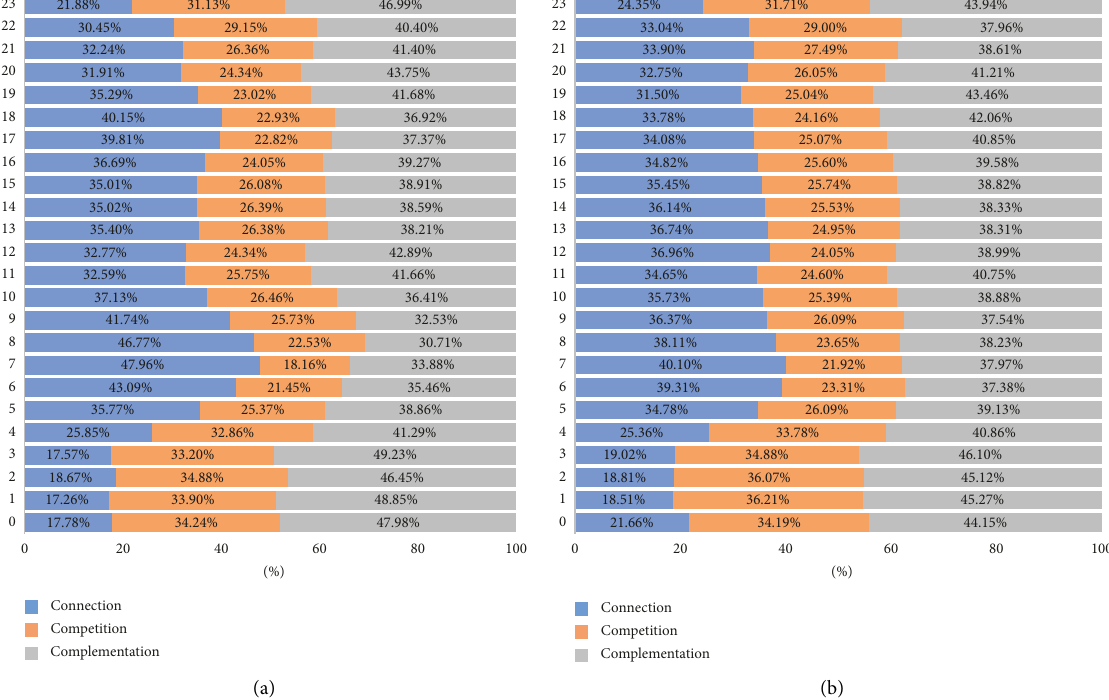
Connection Competition